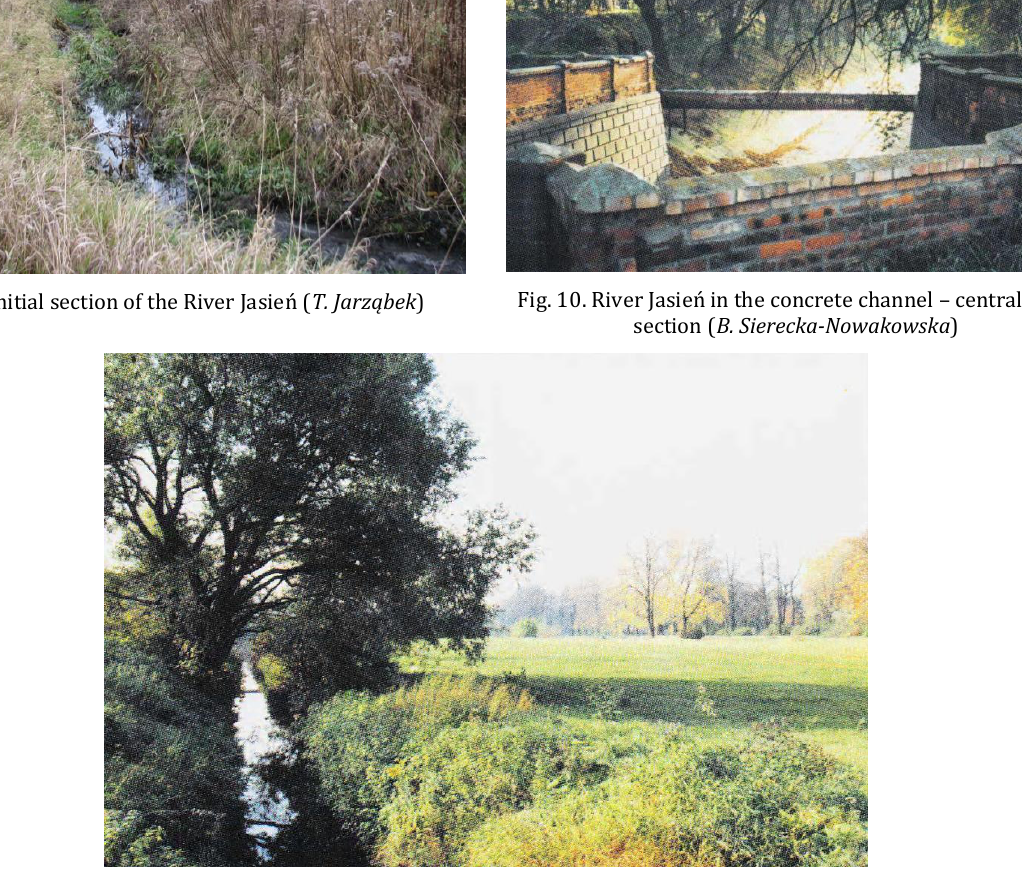
Fig. 11. River Jasień in open areas in the western – estuarine section ( B. Sierecka-Nowakowska